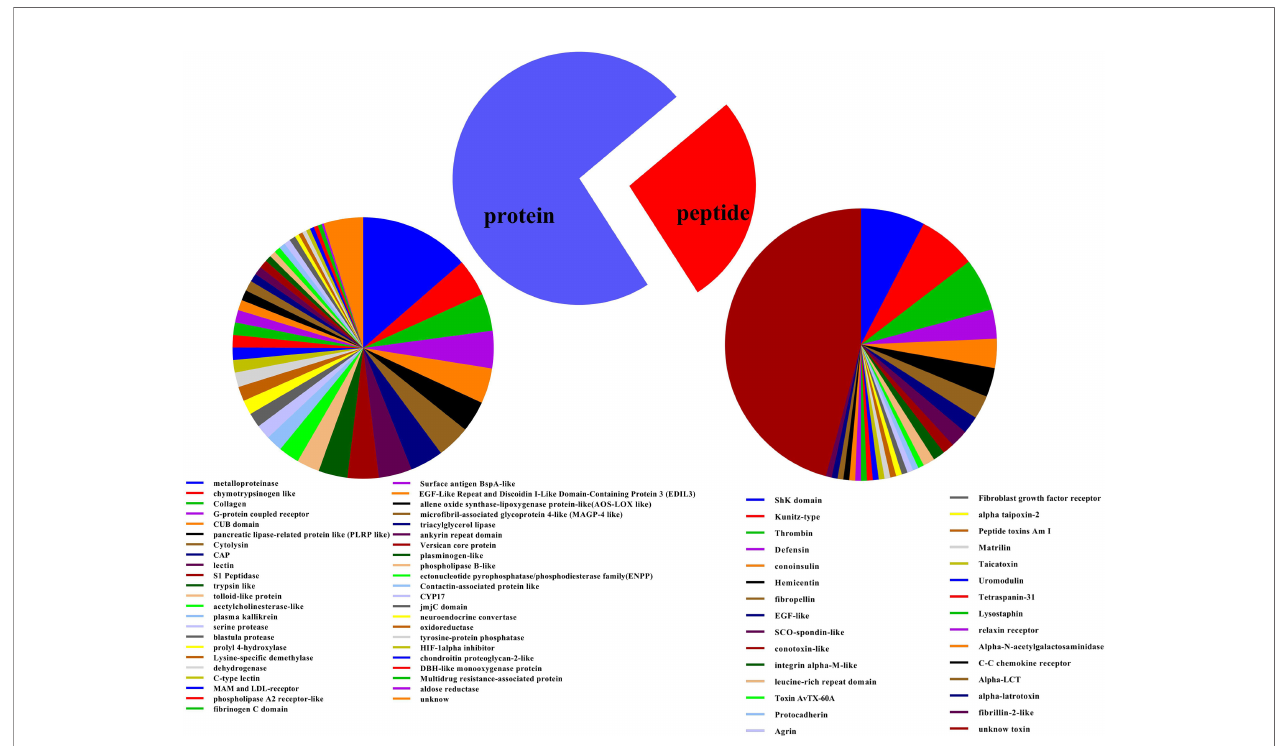
FIGURE 1 | Putative protein as well as peptide toxin families in transcriptome of Exaiptasia diaphana . The 533 protein sequences with substantial BLAST hits to manually curated lists of animal toxins in UniProt (www.uniprot.org/program/Toxins) were allocated into various toxin families based on their amino acid sequences and cysteine